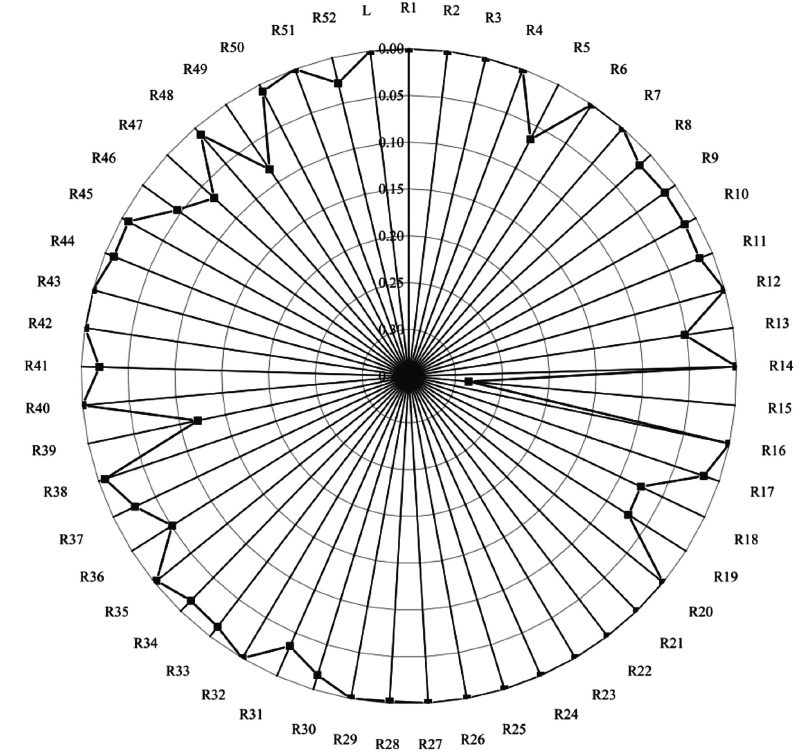
Figure 9. Betweenness centrality of each